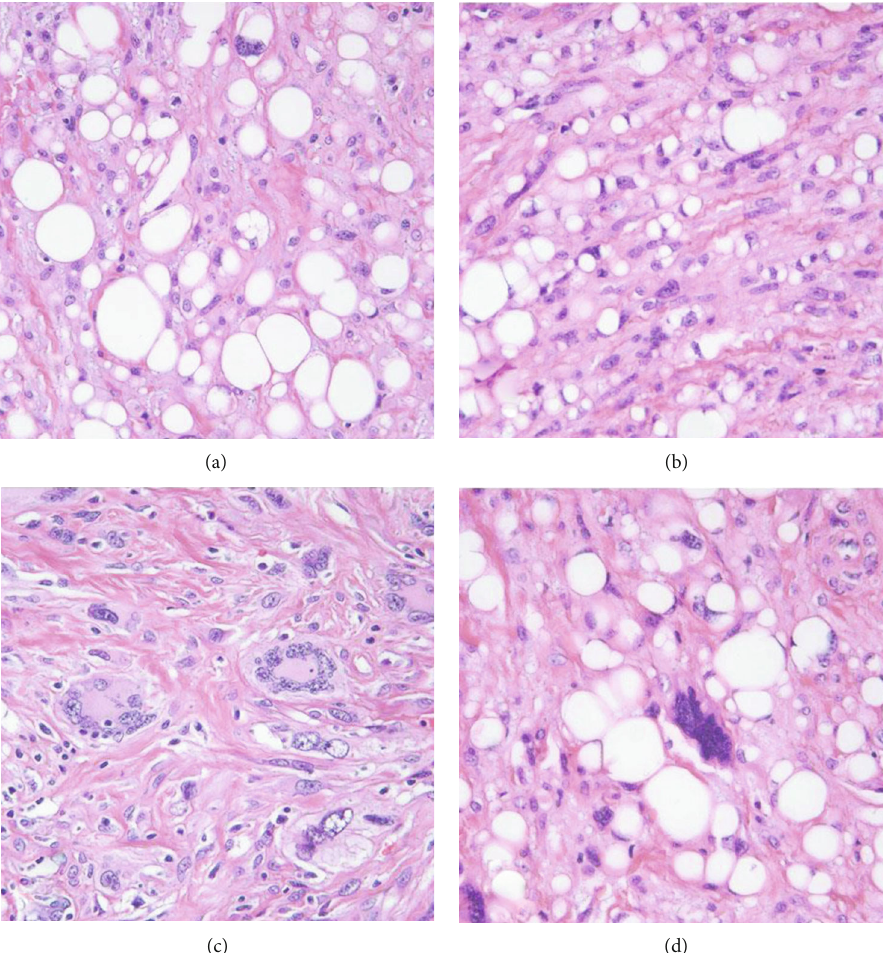
Figure 3: (a) Multivacuolated lipoblast surrounded by lipocytes that vary markedly in size and shape (H&E, 400x). (b) Area where univacuolar lipoblasts with scalloped nuclei predominate amid spindle cells with ovoid nuclei and the presence of ropey collagen (H&E, 400x). (c) Multinucleated giant cells with hints of ropey collagen (H&E, 400x). (d) Strikingly “ bizarre ” pleomorphic cell (H&E, 400x).